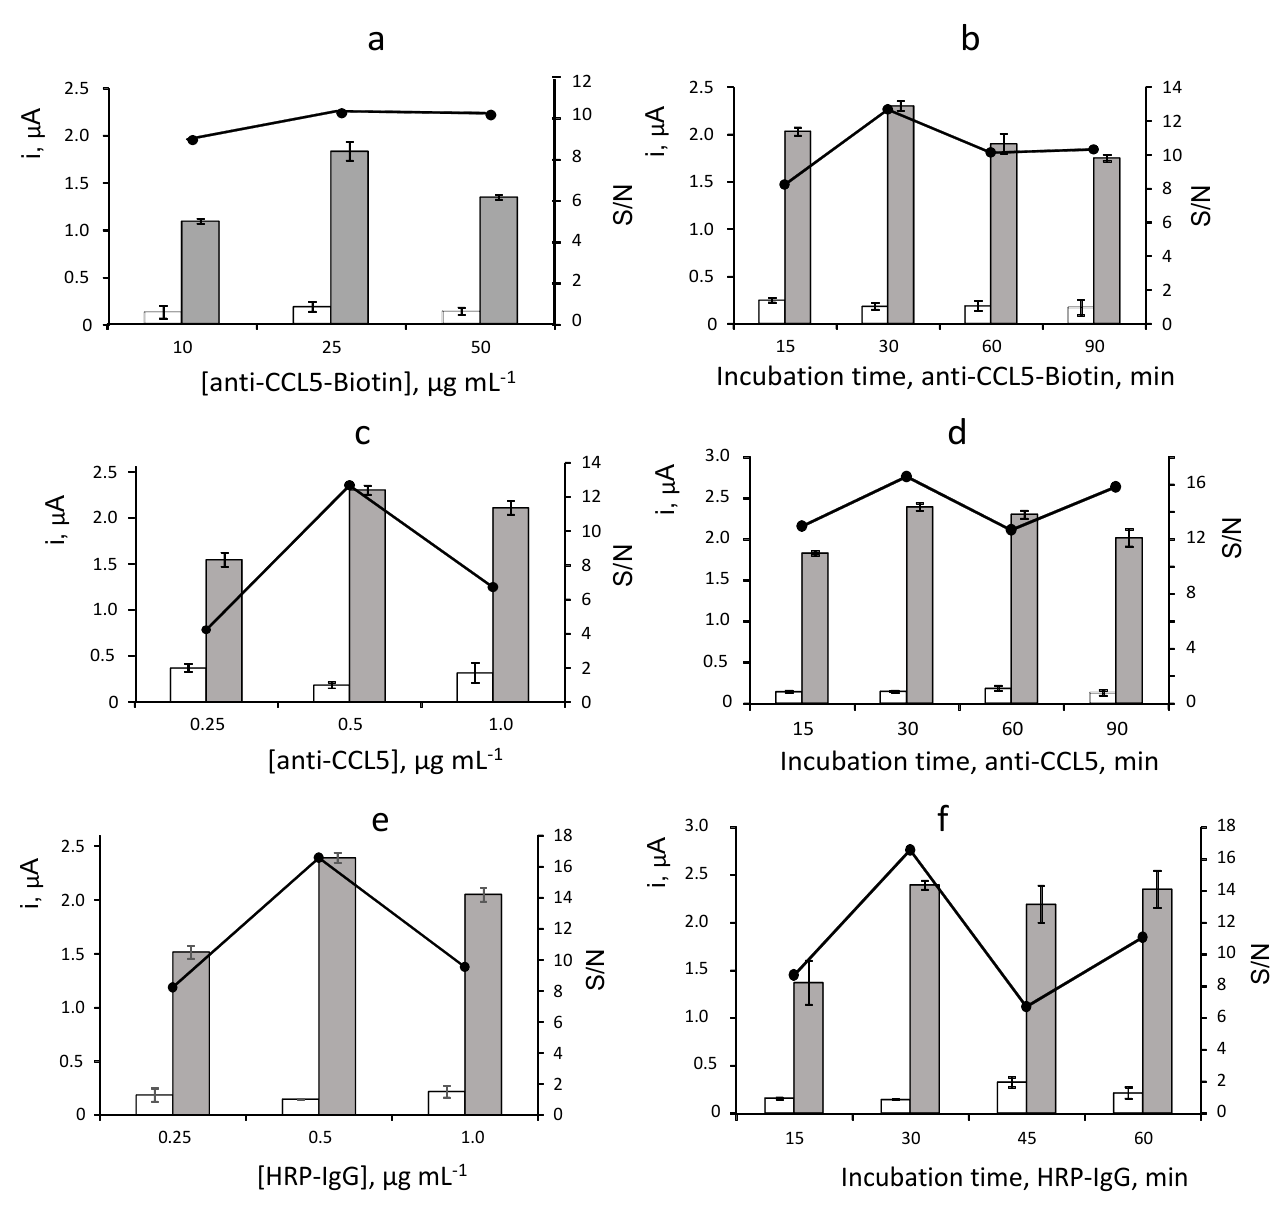
Figure 2. Biotin loading ( a ) and incubation time ( b ) onto Neu–MBs, anti–CCL5 loading ( c ) and